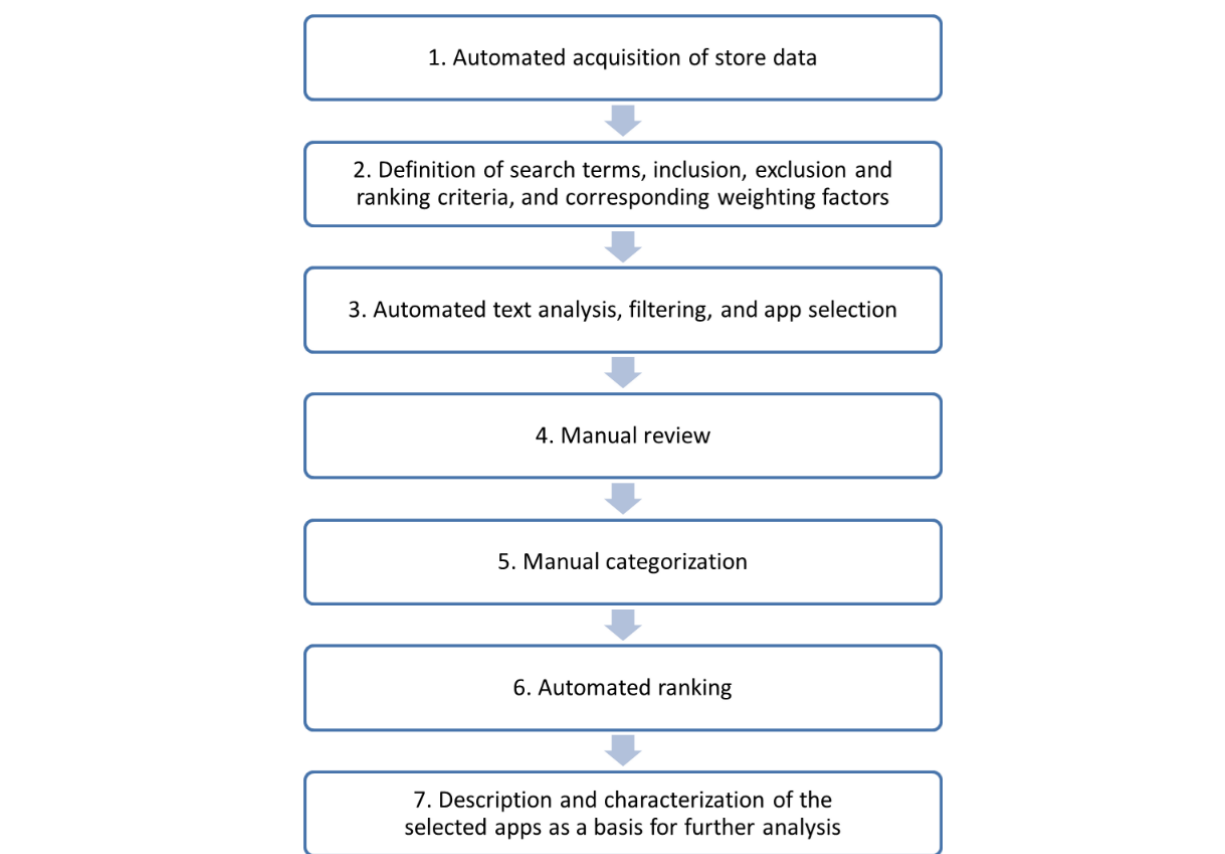
Figure 1. The 7 steps of the semiautomated retrospective app store analysis (SARASA)